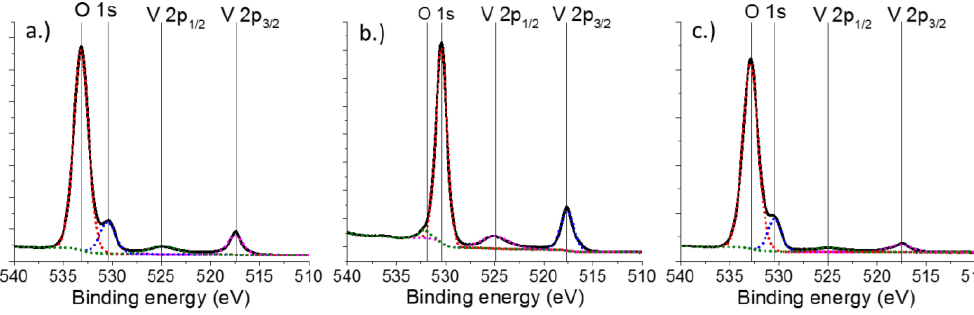
Figure 2. Electron spectra of ( a ) 1.5V/Si; ( b ) 1.5V/Ti; ( c ) 1.5V/SiTi(30) (calcined at 500 °C) studied with XPS.